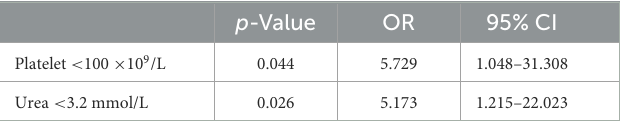
TABLE 5 Risk factors for mortality of Pseudomonas aeruginosa infection with multivariate logistic regression